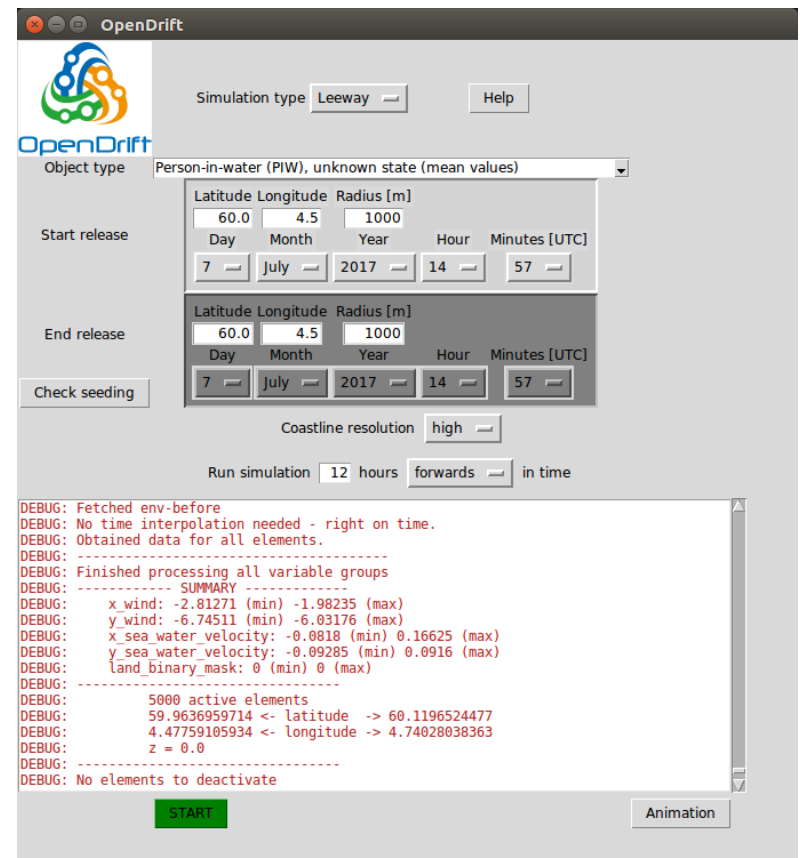
Figure 7. Screenshot of the graphical user interface included with